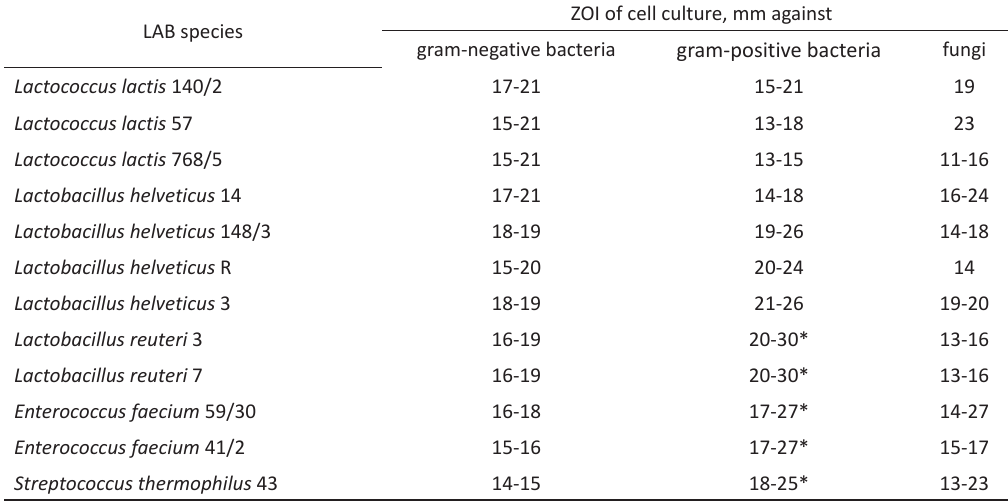
Table 1. Zones of inhibition of tested LAB against indicator strains LAB